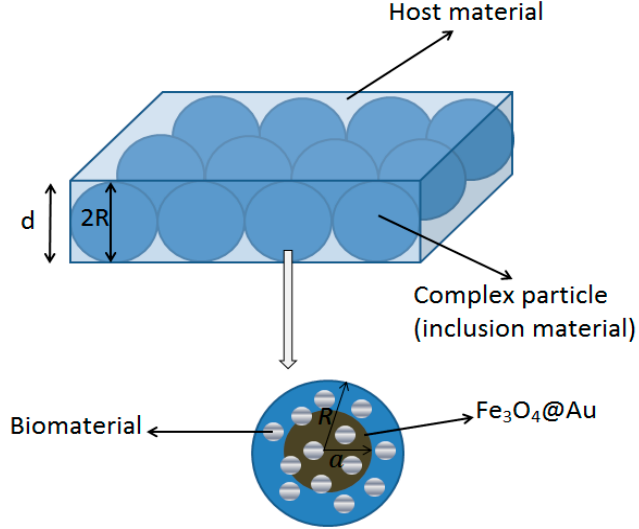
Figure 2. The composite model contains the complex particle (inclusion material) and the host material.